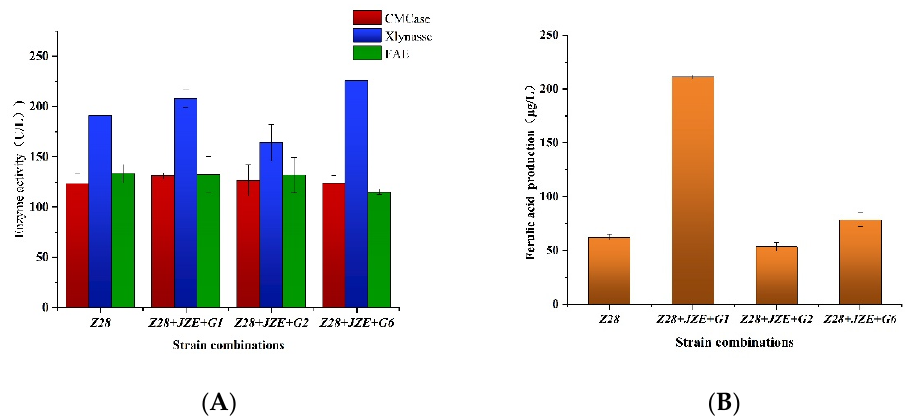
Figure 2. Analysis of enzyme activity ( A ) and FA production ( B ) during the combined culture of feruloyl esterase-producing strains, xylanase-producing strains, and CMCase-producing